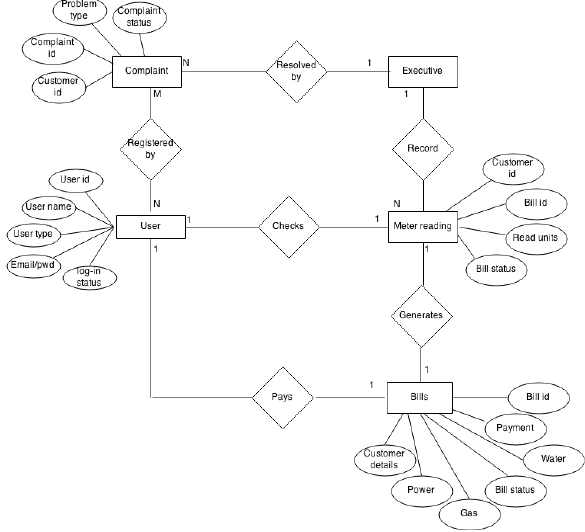
Figure 7. Entity Relationship Diagram in detail for the proposed system